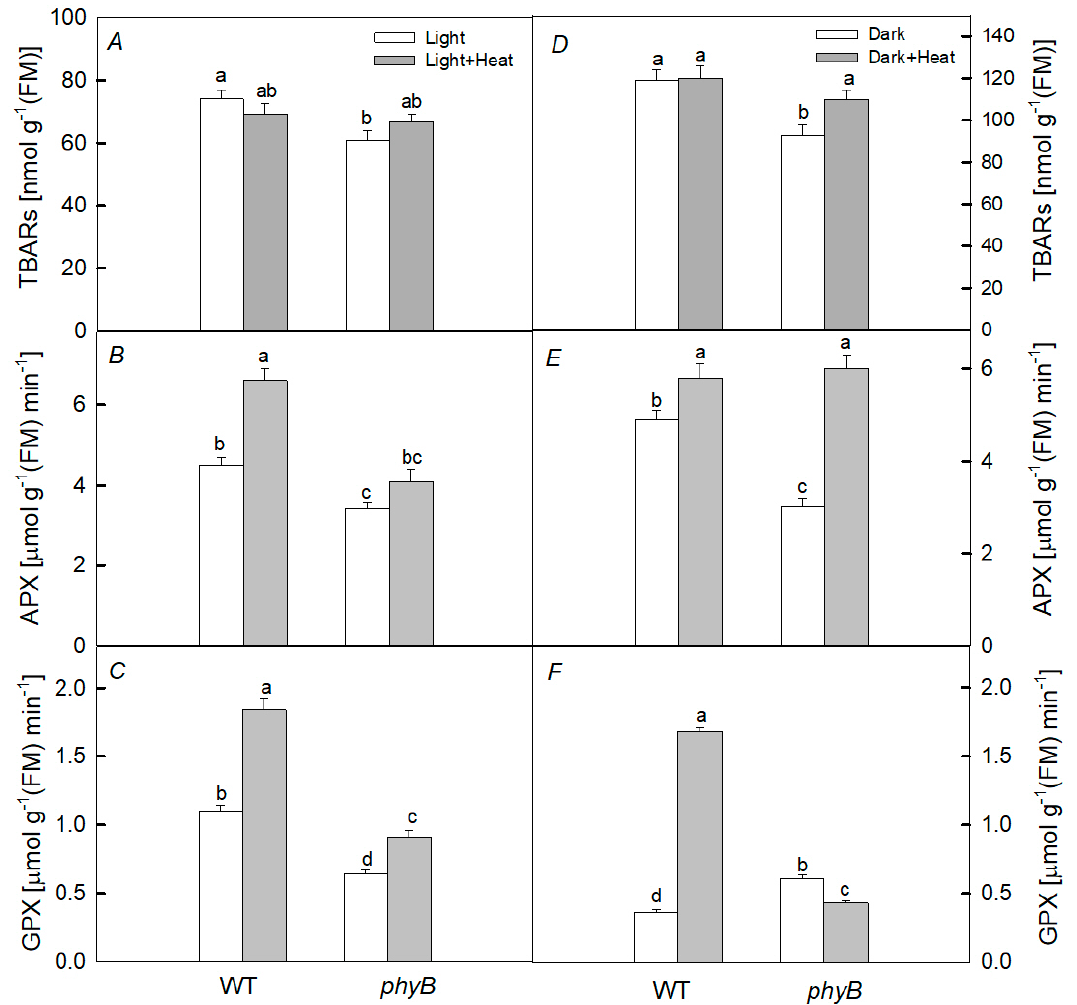
Figure 4. Effect of 2 h heat treatment 40 °C under light ( A – C ) and dark ( D – F ) conditions on the activity of the antioxidant enzymes ascorbate peroxidase (APX) ( B , E ) and guaiacol-dependent peroxidase (GPX) ( C , F ), as well as the content of thiobarbituric acid reactive substances (TBARs) ( A , D ) in the leaves of WT and phyB mutant plants. Mean values ± SD are shown ( n = 4). Different letters correspond to a significant difference in values at p < 0.05.